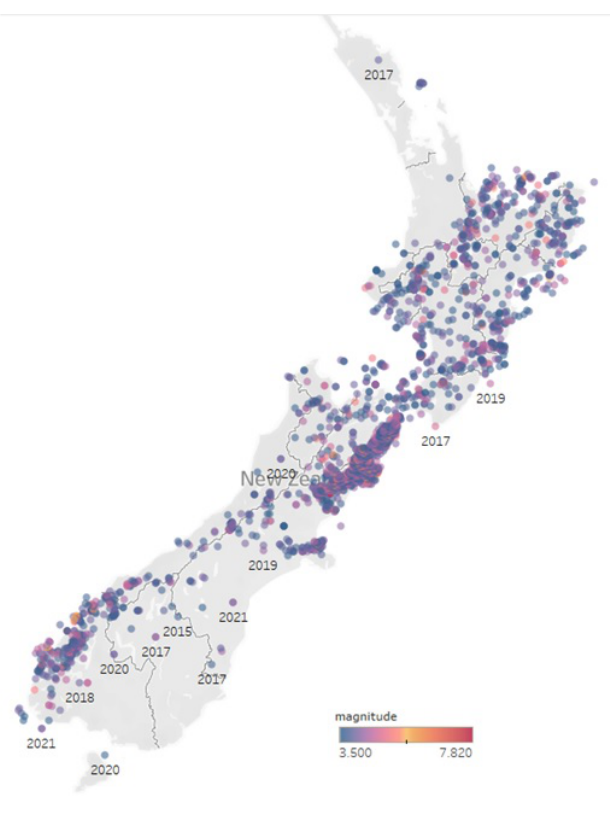
Figure 1. The earthquake data visualization of New Zealand